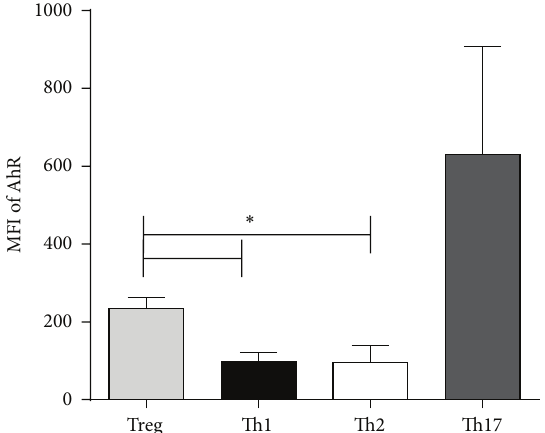
Figure 5: Expression of AhR on T cell subsets. Isolated PBMCs ( 𝑛 = 5 individual subjects) were stained with fluorescently conjugated AhR antibodies, gated for Treg, Th1, Th2, or Th17 cell subsets and simultaneously assessed for AhR expression (as shown by median fluorescence intensity (MFI)). Error bars show SD; ∗ 𝑃 < 0.05